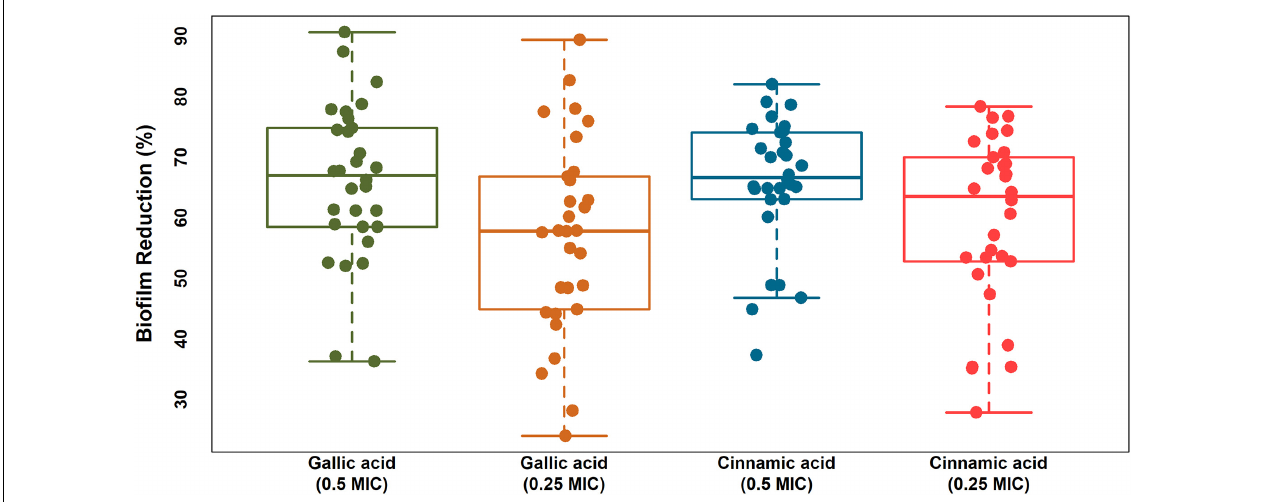
FIGURE 5 | Boxplots displaying biofilm reduction (%) caused by subinhibitory concentrations (1/2 and 1/4 MICs) of cinnamic and gallic acids. A strip chart displaying individual isolates was overlaid to illustrate the real dispersal of reduction percentages. The means were significantly different [ANOVA F (3), p = 0.0198]. Plot was created by R (“ggplot2”)